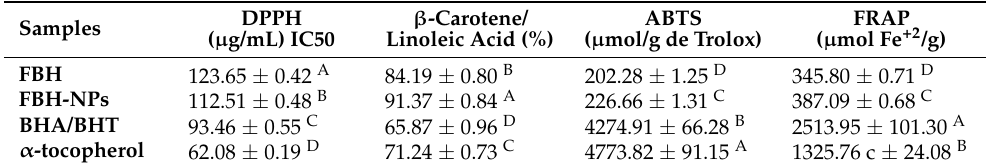
Table 2. Antioxidant activity of FBH and